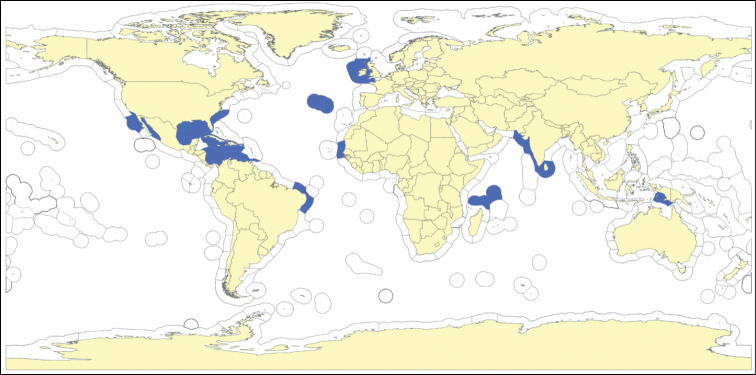
Idealized global distribution of the genus Cyamon, showing presence of the genus in Marine Ecoregions of the World (Spalding et al. 2007).